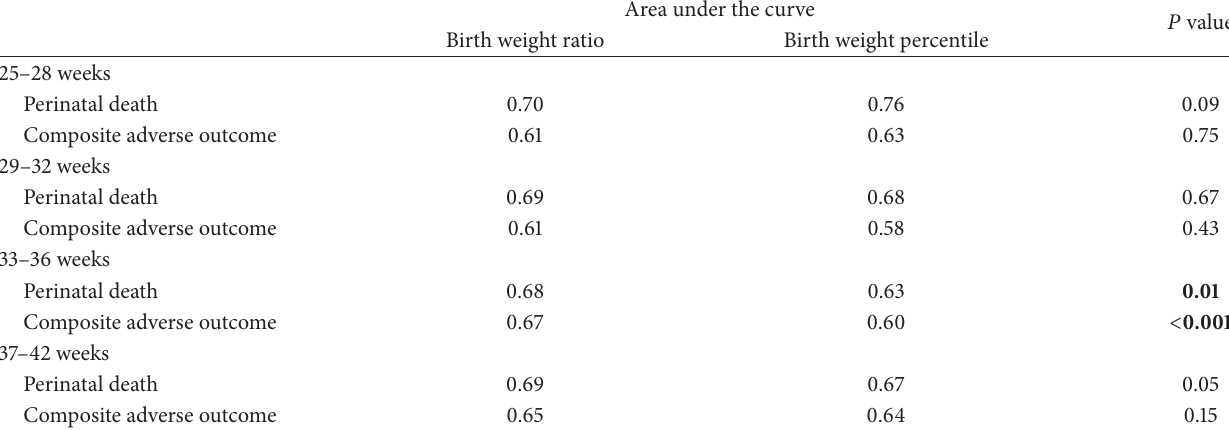
Table 4: Discriminative ability of birth weight ratio and birth weight percentile in case of birth weight below the 10th percentile for gestational